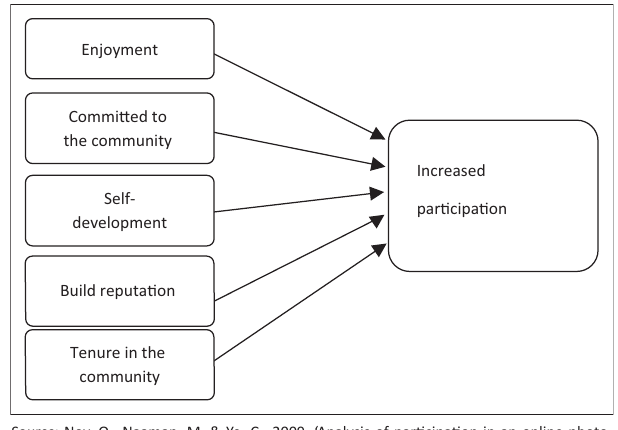
FIGURE 2: Citizen community participation